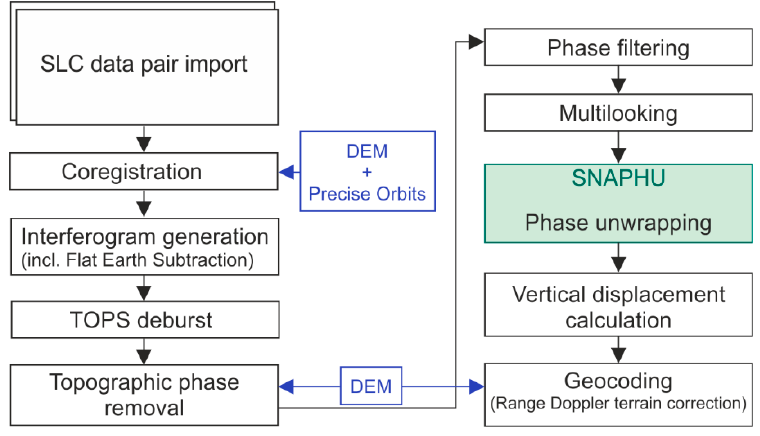
Figure 4. Single-pair DInSAR workflow in SNAP.